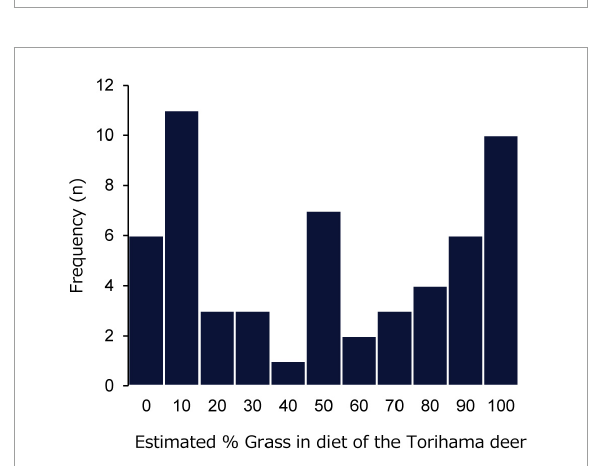
Rivals and Takatsuki, 2015). Microwear can also be